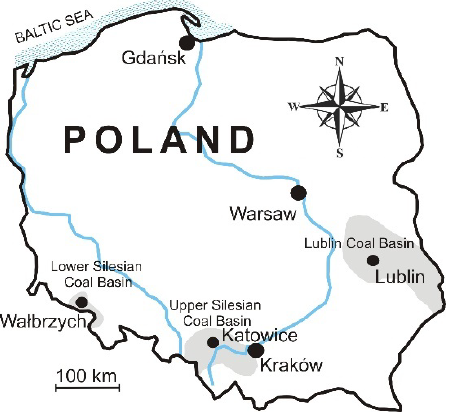
Figure 1. Location of the Upper Silesian Coal Basin in Poland.